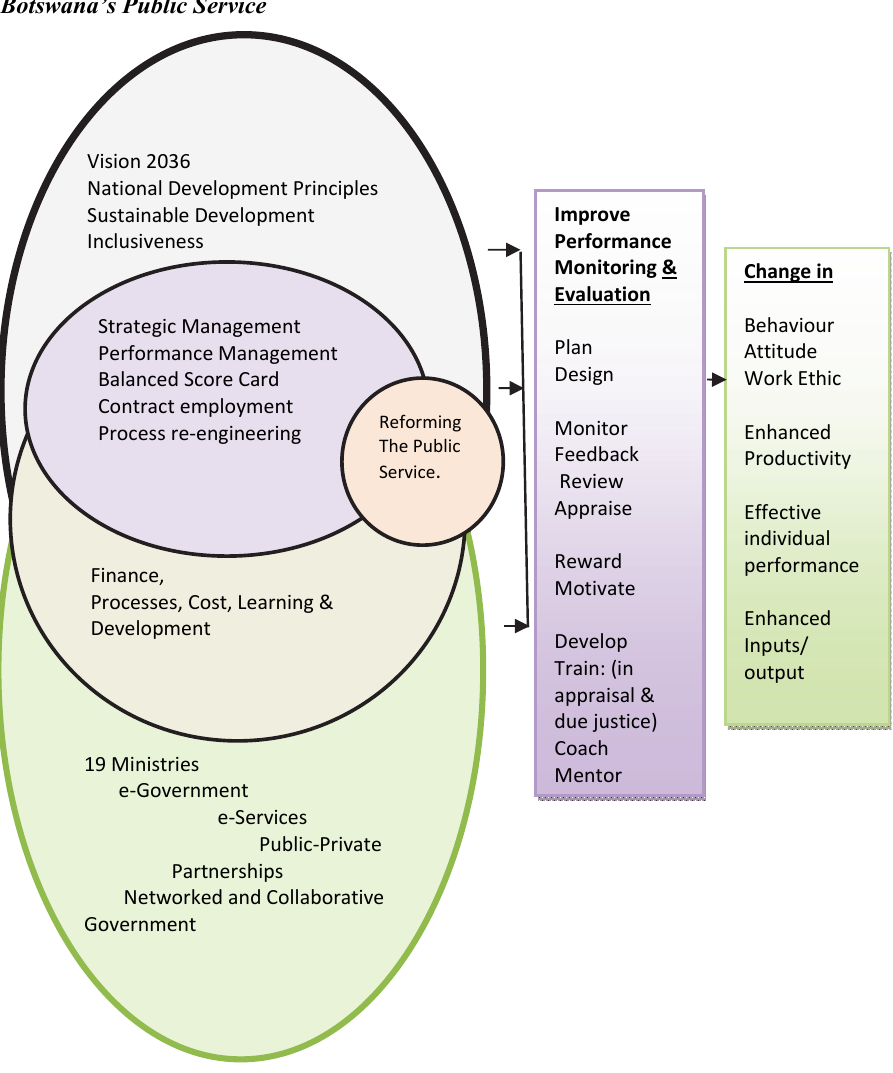
Figure 7: Performance Monitoring and Evaluation Developmental Model for Botswana’s Public